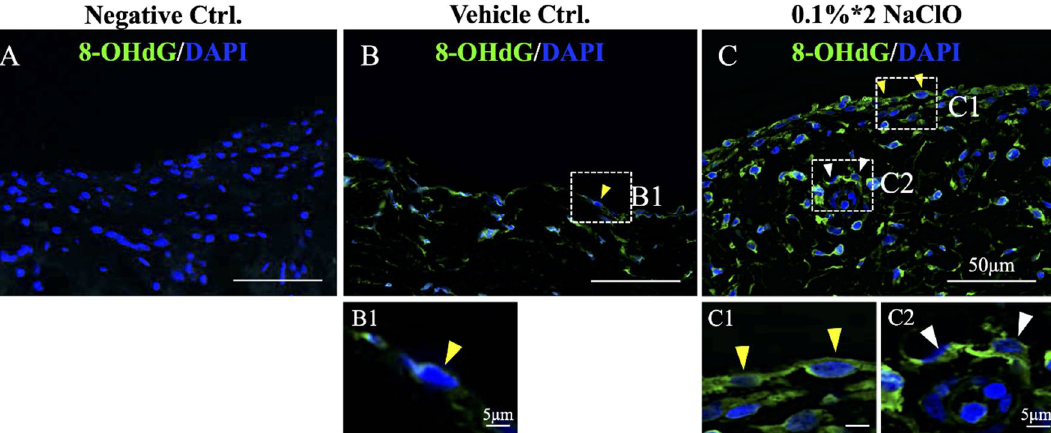
Figure 2. Detection of oxidative damages on both mesothelium and vessel endothelium in NaClO- injured pigs. ( A ) Primary antibody of 8-OHdG was not added for negative control. ( B , C ) After 0.1%*2 NaClO injury, signal of 8-OHdG, a marker for DNA oxidative damage became significantly stronger and distributed across all kinds of cells on the parietal peritoneum. ( B1 ) Enlarged image depicted a minimal expression of 8-OHdG on mesothelial cells (yellow arrowheads) in control pigs; a significant increase in 8-OHdG signals were detected on both mesothelium ( C1 , yellow arrow- head) and endothelial cells ( C2 , white arrowhead) that surrounded vessels. For each experimental condition, 10 images from 3 different pigs were evaluated and representative images were pre- sented.